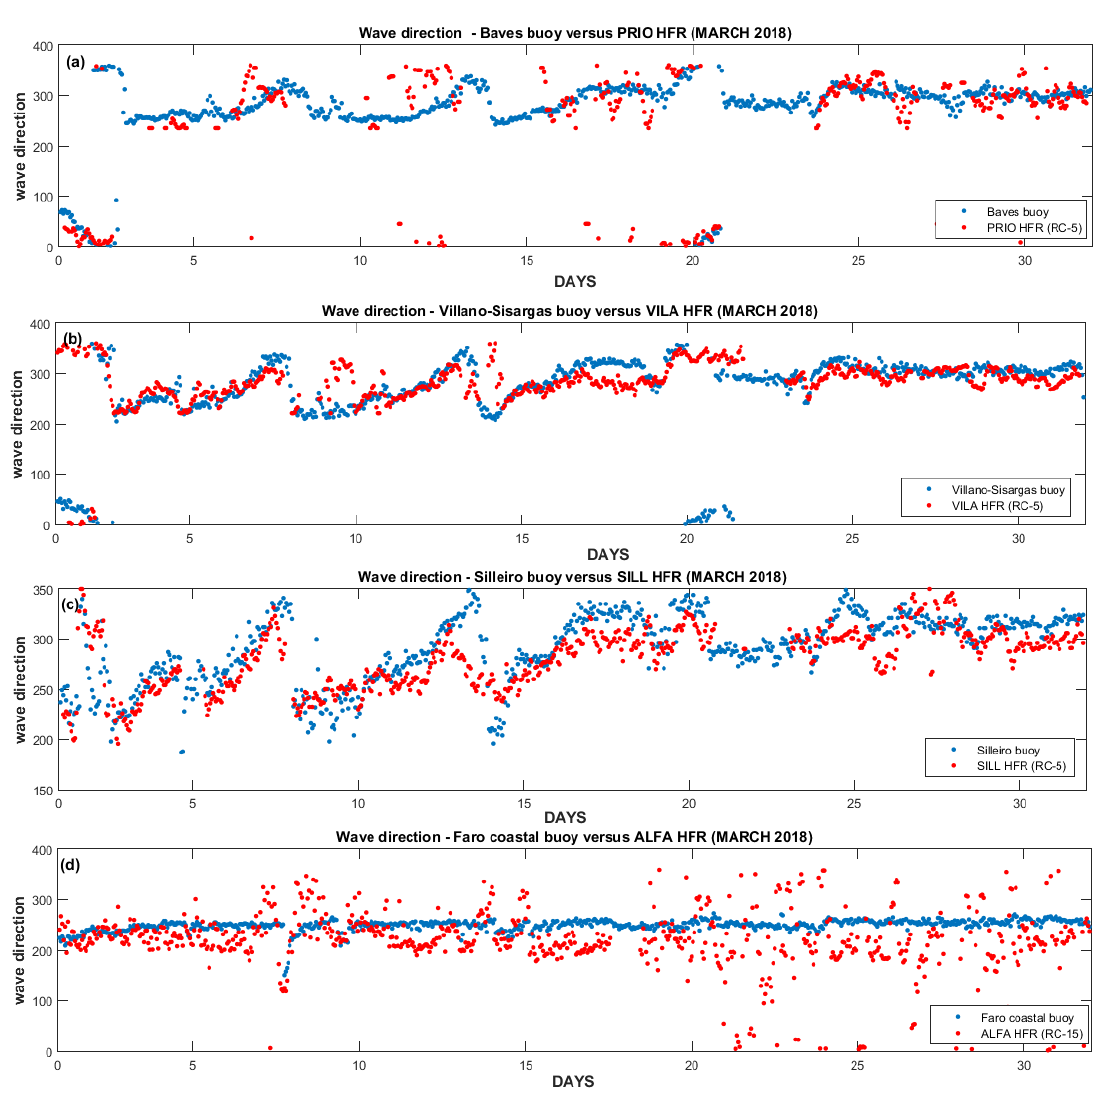
Figure 11. Wave direction time series buoy vs. HFR (March 2018). ( a ) PRIO/Baves buoy; ( b ) VILA/Villano-Sisargas buoy; ( c ) SILL/Silleiro and ( d ) ALFA/Faro coastal buoy. Blue dots: buoy wave direction and red dots: HFR wave direction.